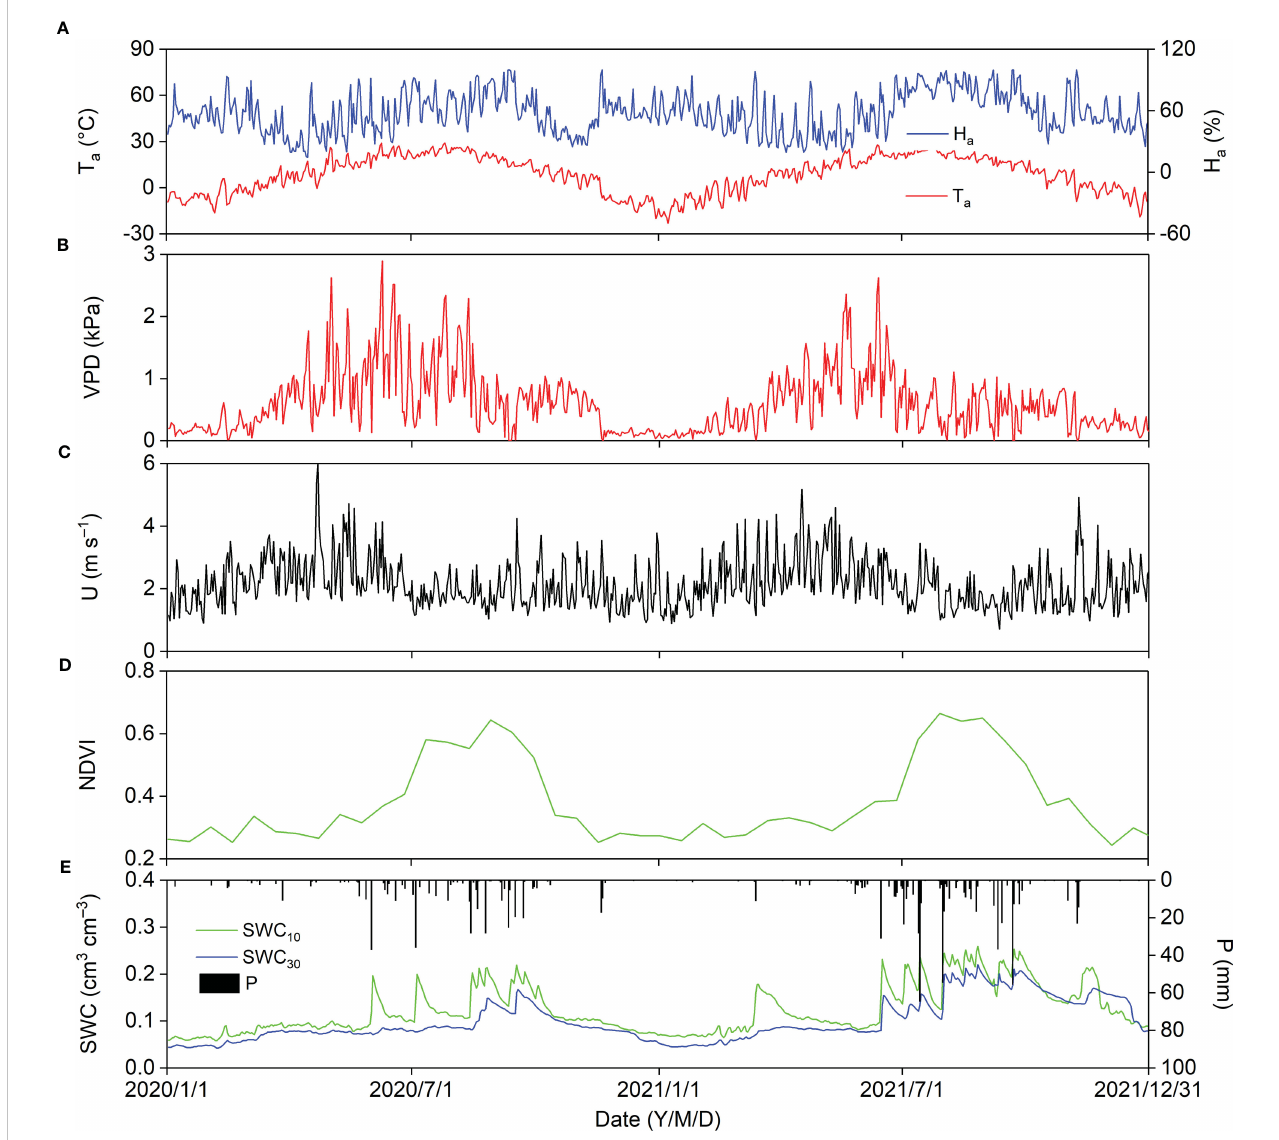
FIGURE 3 Seasonal variations in biophysical factors in 2020 and 2021; biophysical factors are (A) air temperature (T a ) and relative humidity (H a ), (B) vapor pressure de fi cit (VPD), (C) wind speed (U), (D) normalized difference vegetation index (NDVI), and (E) precipitation (P), soil water content at 10 cm depth (SWC 10 ) and 30 cm depth (SWC 30